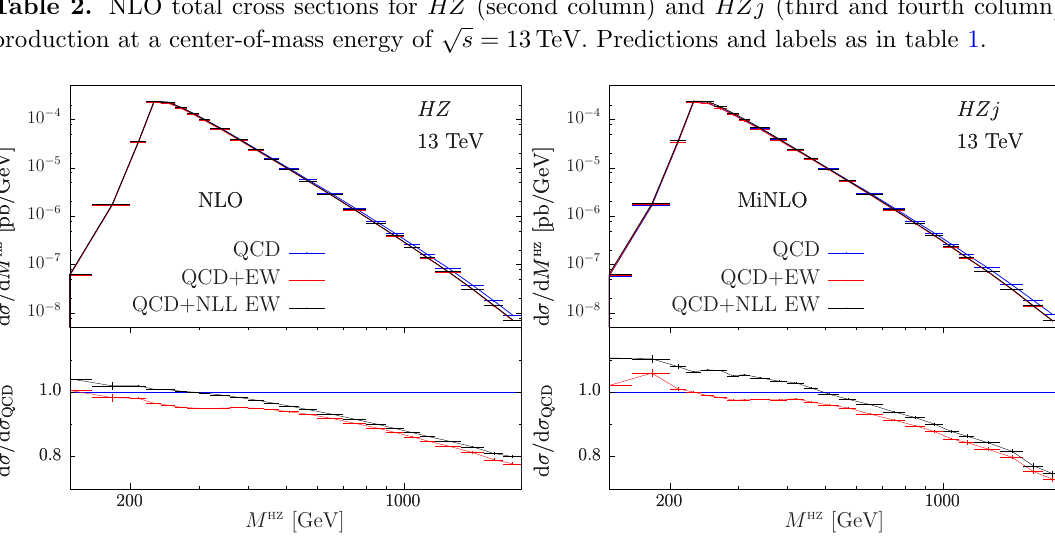
Figure 8. NLO predictions for the invariant mass of the HZ pair in HZ (left) and HZj (right) production. The three curves represent the QCD, QCD+EW and the QCD+NLL EW predictions. The lower panel displays ratios with respect to NLO